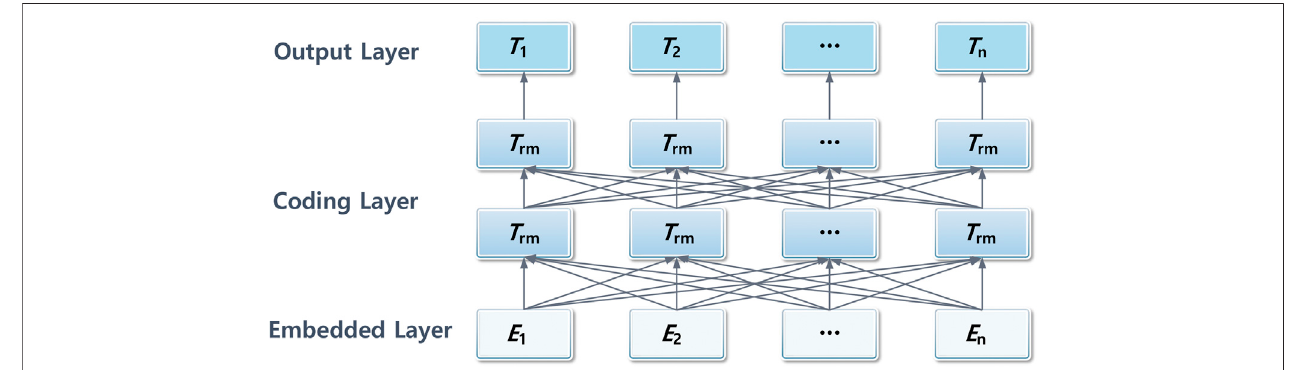
FIGURE 2 | Structure of the Bert model.